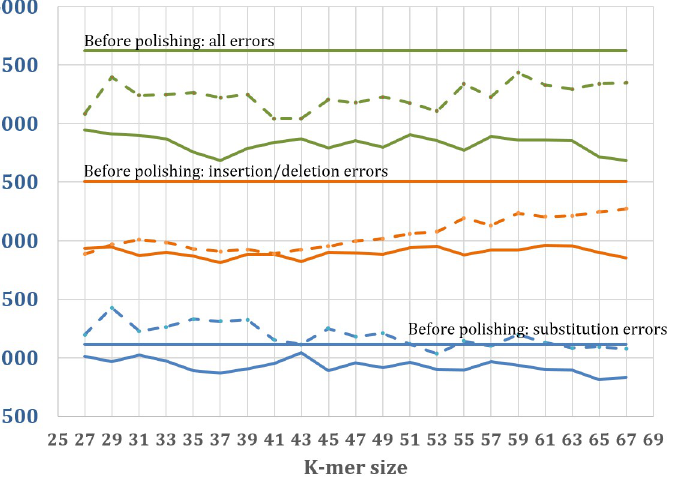
Fig 4. Effectiveness of ntEdit and JASPER polishing on real A . thaliana data as a function of the k-mer size used for polishing. We show the number of remaining substitution errors in blue, the number of remaining indel errors in orange and the total number of remaining errors in green. Solid horizontal lines mark the number of errors before correction. The number of errors remaining is plotted as solid lines for JASPER and dashed lines for ntEdit. JASPER corrects more substitution errors at every k-mer size, and more indel errors at all but two values of k. For all values of k, the total errors remaining is lower for JASPER.